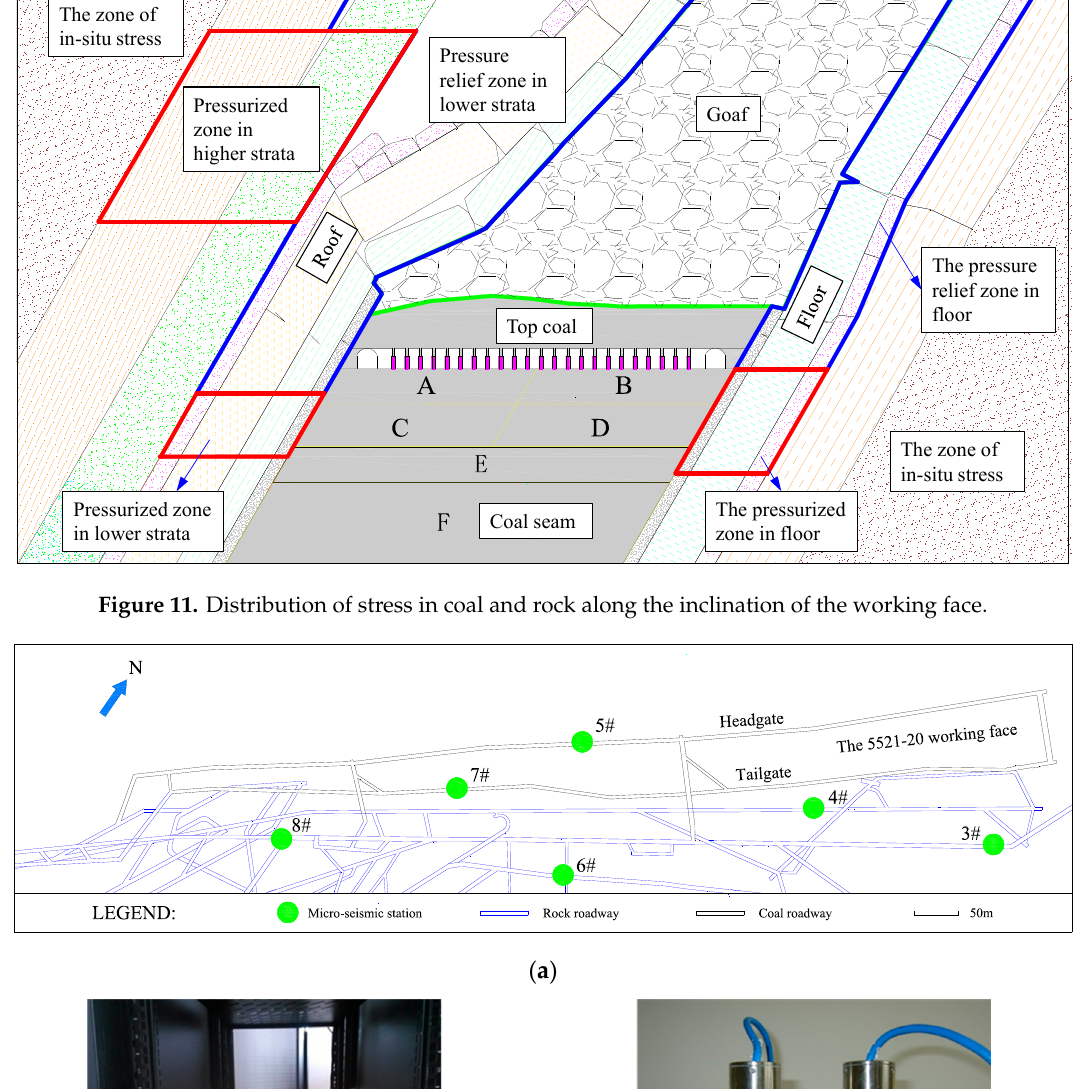
Figure 10. Simulated fracture patterns in bottom coal of working face: ( a ) Plastic state of zones in bottom coal; and ( b ) Distribution of cracks (shear cracks in red and tensile cracks in blue) in bottom coal.